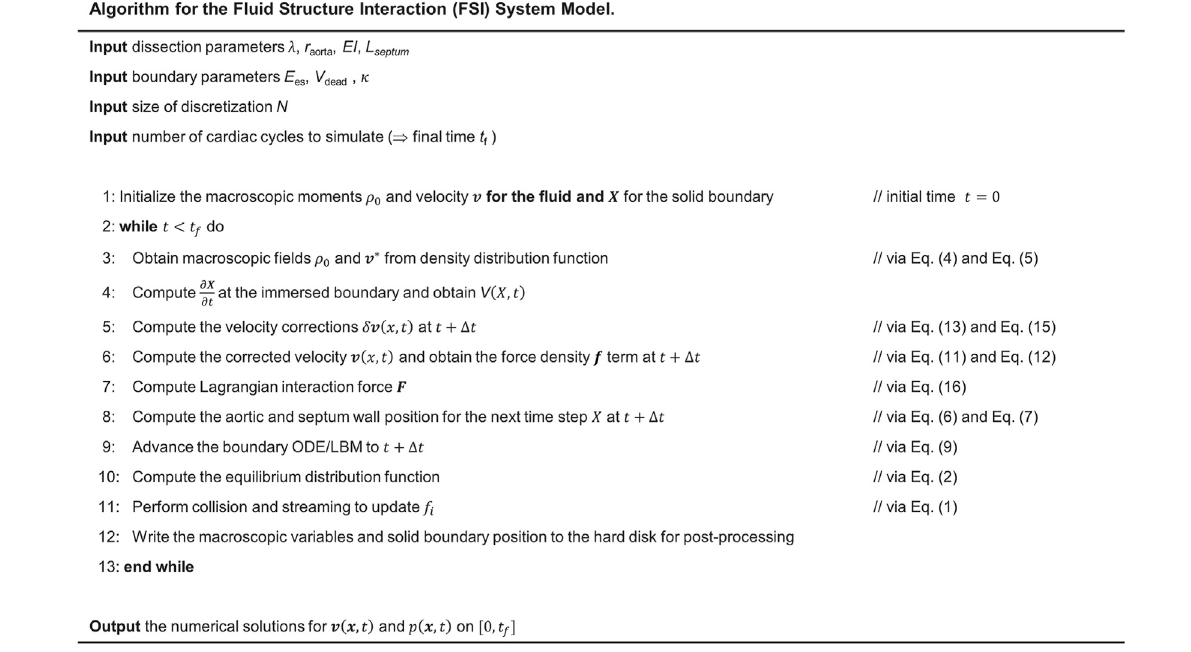
Frontiers in Bioengineering and Biotechnology |